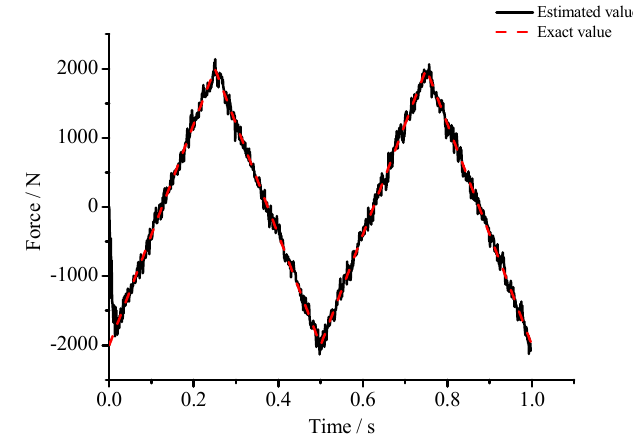
Figure 5. Estimation results of the triangular input force ( Q w = 1 × 10 − 4 , σ = 1 × 10 − 8 ) .